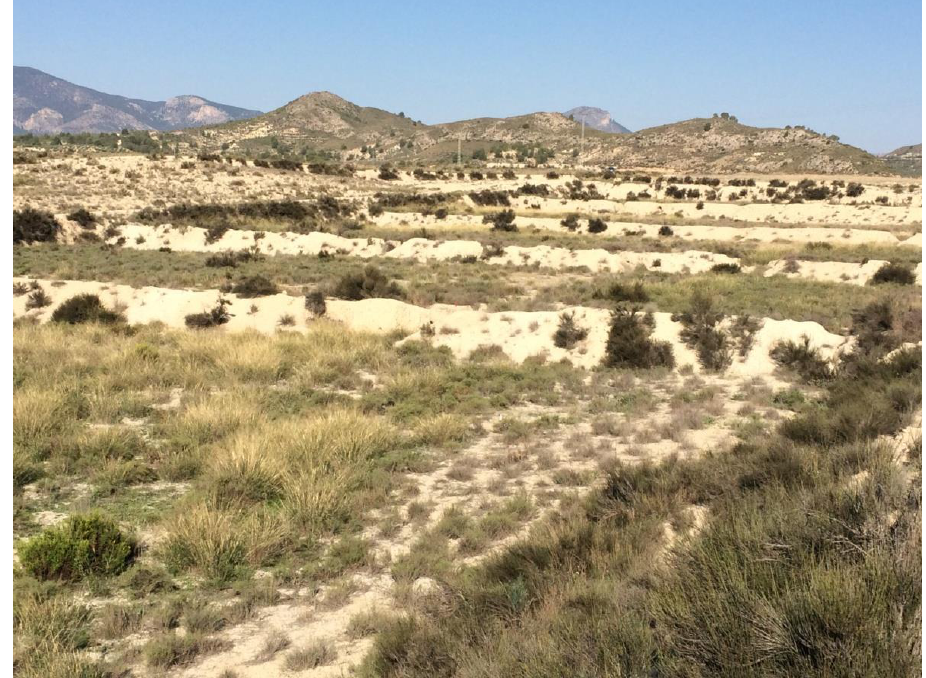
Figure 2. Abandoned terraces in the Upper Guadalentin basin in Murcia (southeast Spain). Land abandonment and slow revegetation produce soil erosion processes. Photo by Estela Nadal-Romero.